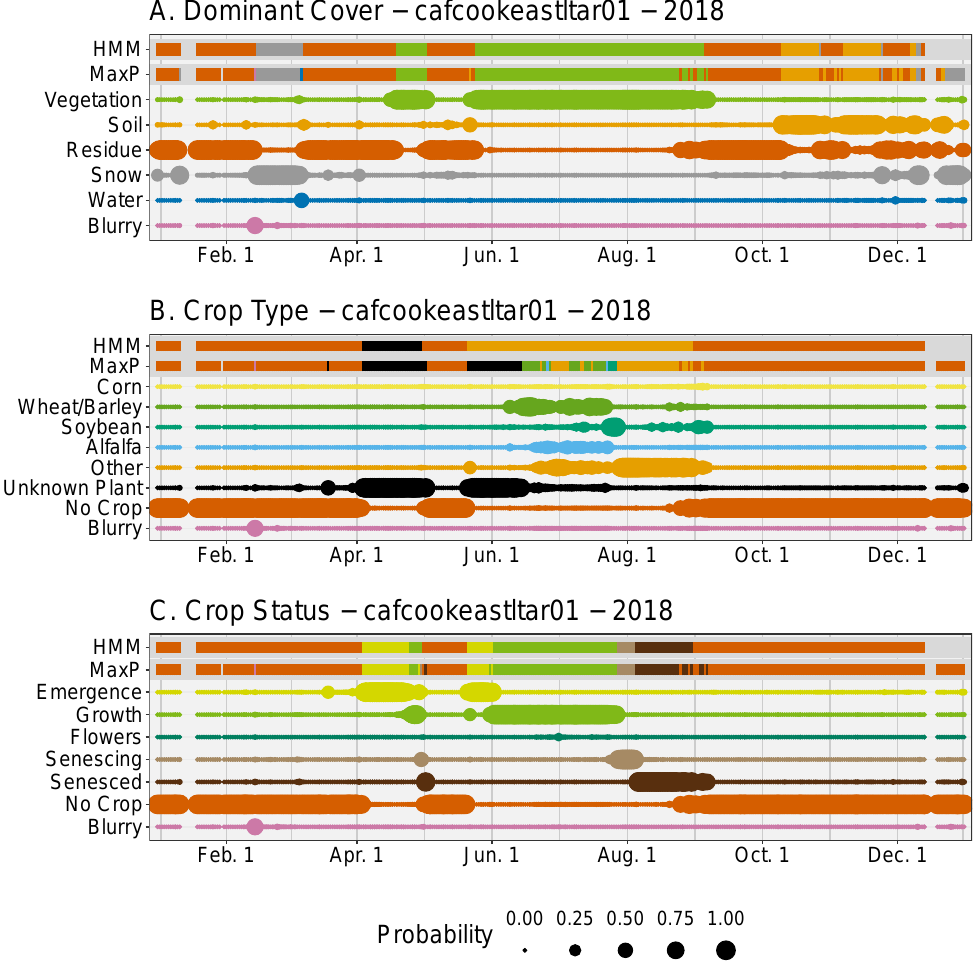
Figure 6. Classification results for the cafcookeastltar01 site for the year 2018. The panels represent the results for the Dominant Cover ( A ), Crop Type ( B ), and Crop Status ( C ) categories. The top two rows of each panel represent the final classification for either the daily maximum probability (MaxP) or the hidden Markov model (HMM). The remaining rows in each panel represent the initial model classification for the respective class, where larger sizes represent higher